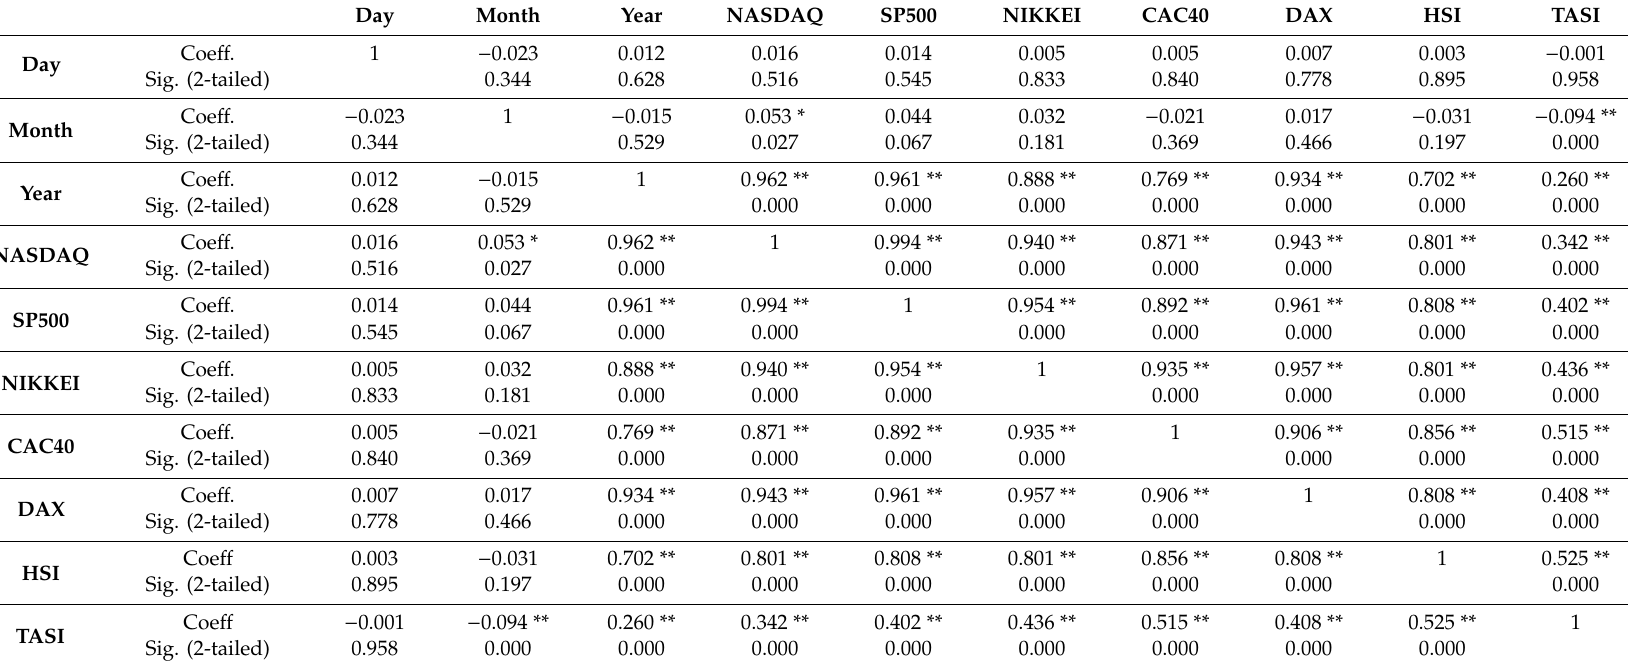
Table 3. The correlation matrix of International indices and